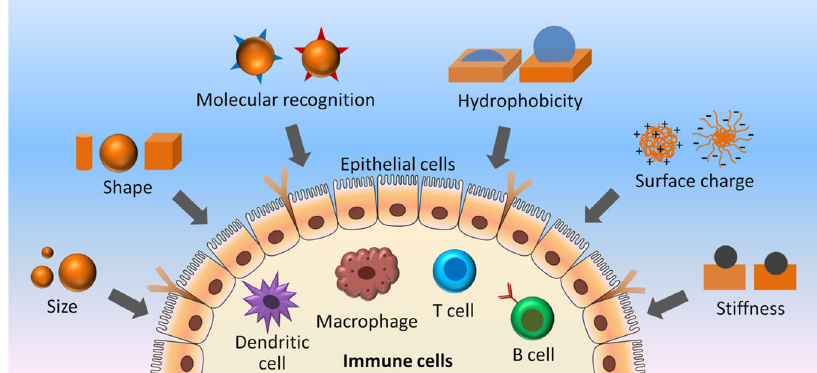
Fig. 5 Schematic of design consideration for RLP-based smart nanoparticle and hydrogel systems to enable immunomodulation. Design elements, including size, shape, molecular recognition, hydrophobicity, surface charge and stiffness of RLP-based biomaterials can modulate their immune cell (dendritic cells, macrophages, T cells, B cells, etc.) interaction and molecular